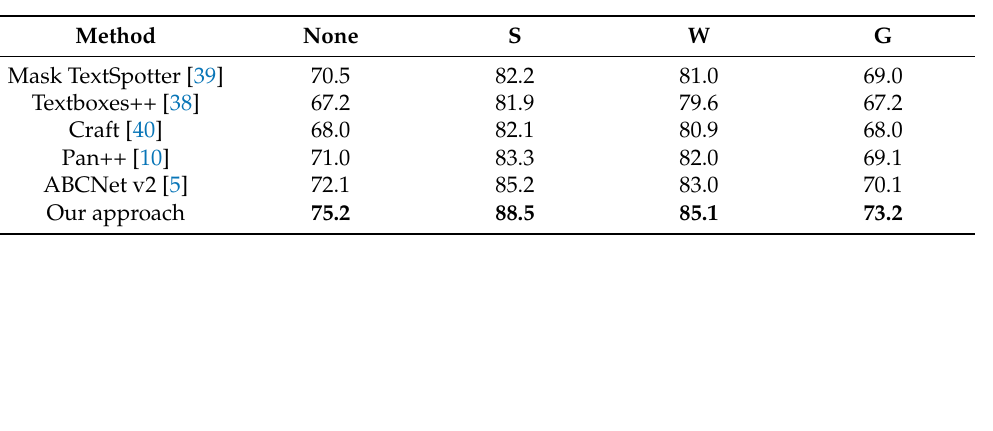
Table 4. End-to-end text spotting comparison with state-of-the-art methods on our dense scene text dataset. “None” represents lexicon-free. “S”, “W”, and “G” represent recognition with Strong, Weak, and Generic lexicon,